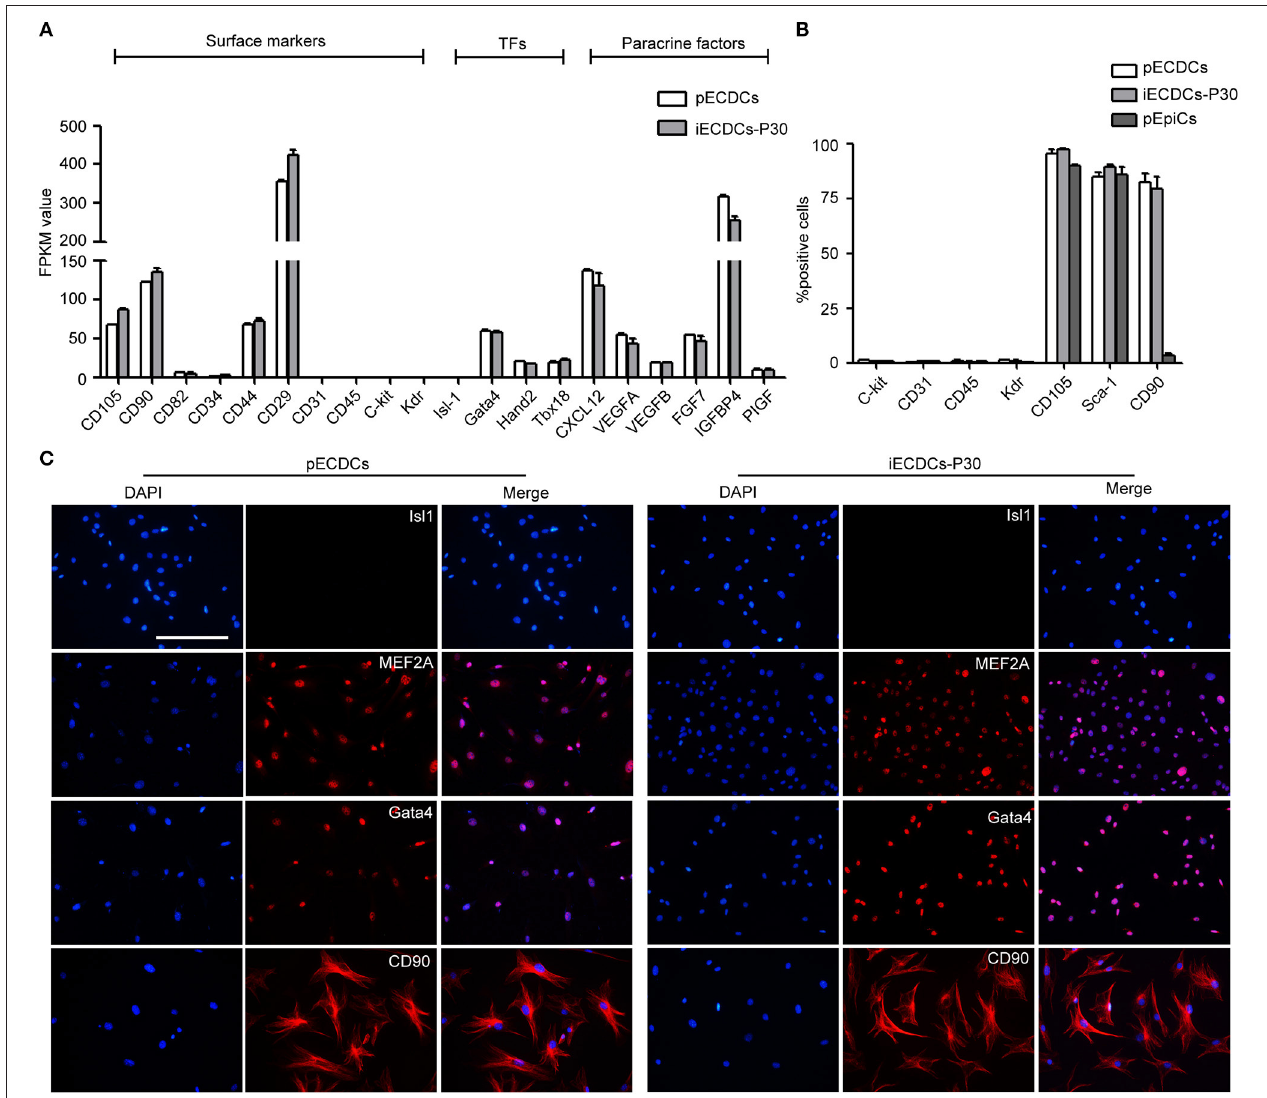
FIGURE 3 | Lineage specification of pECDCs and iECDCs. (A) The expression of surface markers, transcription factors, and paracrine factor genes of pECDCs and iECDCs. The pECDCs and iECDCs at passage 30 were used for RNA sequencing. Fragments Kilobase of exon model permillon mapped reads (FPKM) values were used for quantification of gene expression level. Data represent mean ± SEM ( n = 3). (B) Flow cytometric analysis of cell surface markers of pECDCs, pEpiCs, and iECDCs at passage 30, using anti-c-kit, CD31, CD45, Kdr, CD105, CD90, and stem cell antigen-1 (Sca-1) antibodies. Data represent mean ± SEM ( n = 3). (C) Immunostaining of CDC cell markers for pECDCs and iECDCs (scale bar = 100 µ